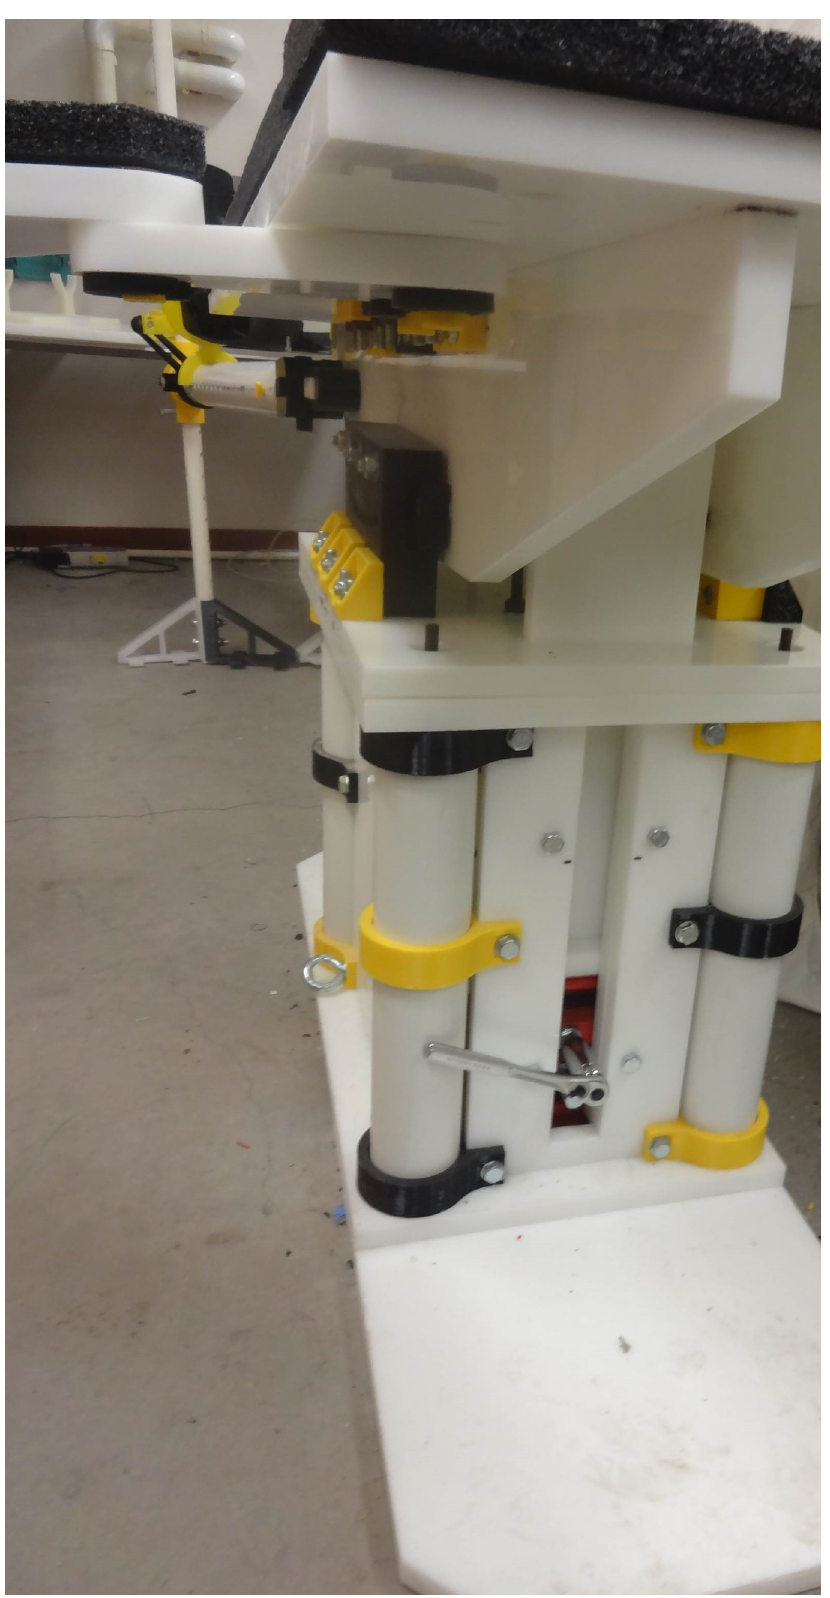
Fig 29. Details of wrench used to control heights of motor cycle jack and thus the table surface. https://doi.org/10.1371/journal.pone.0270328.g029 PLOS ONE | https://doi.org/10.1371/journal.pone.0270328 July 15,